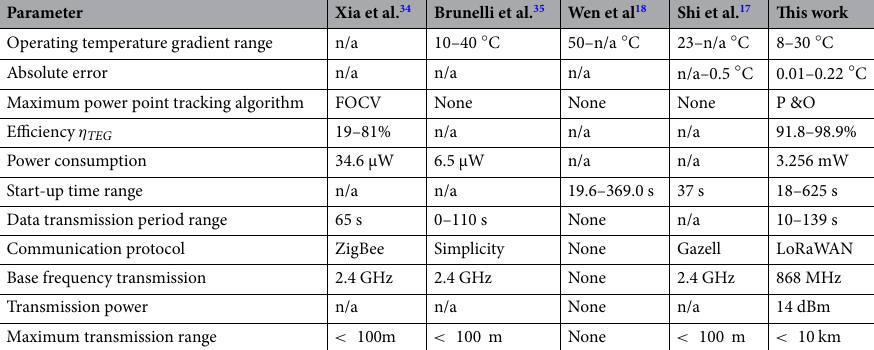
Table 1. Summary of the obtained results versus other state-of-the-art solutions.